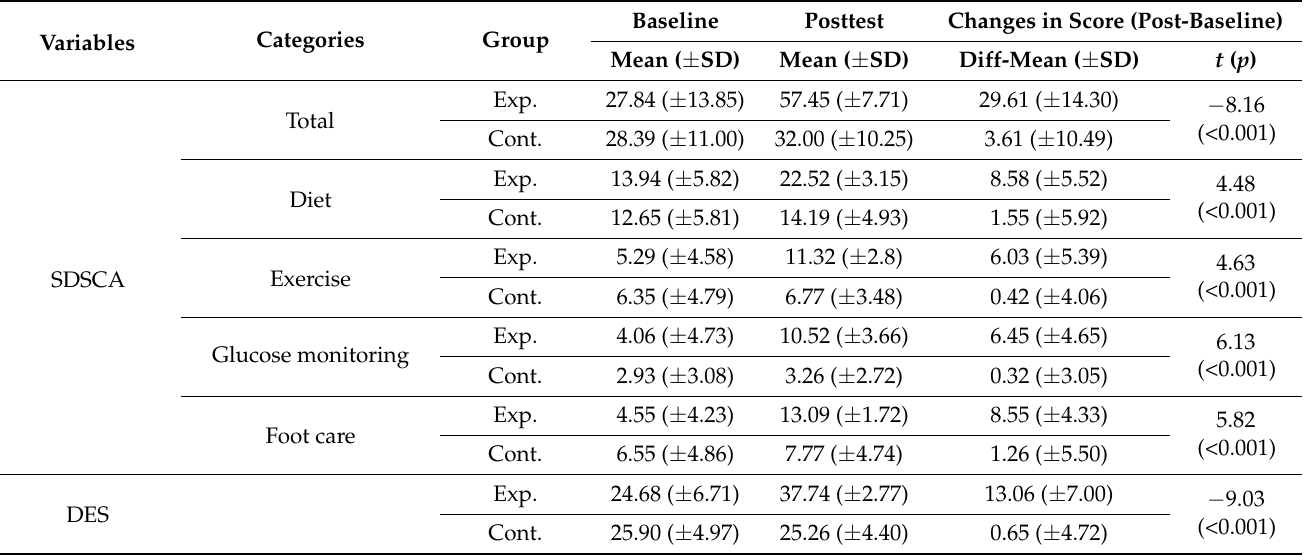
Table 3. Changes in the primary outcomes between the groups (Exp. = 31, Cont. =